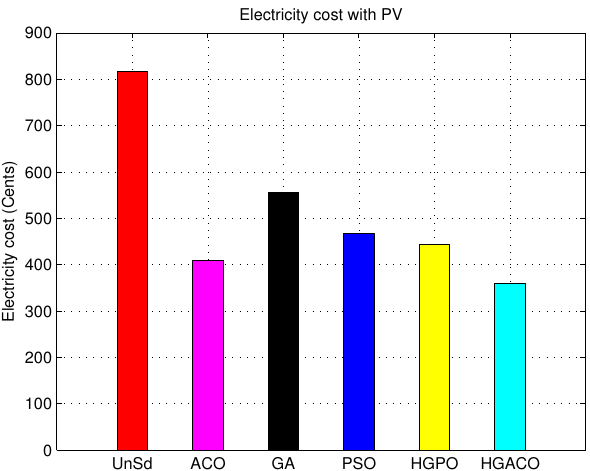
Figure 13. Electricity cost with photovoltaic systems.